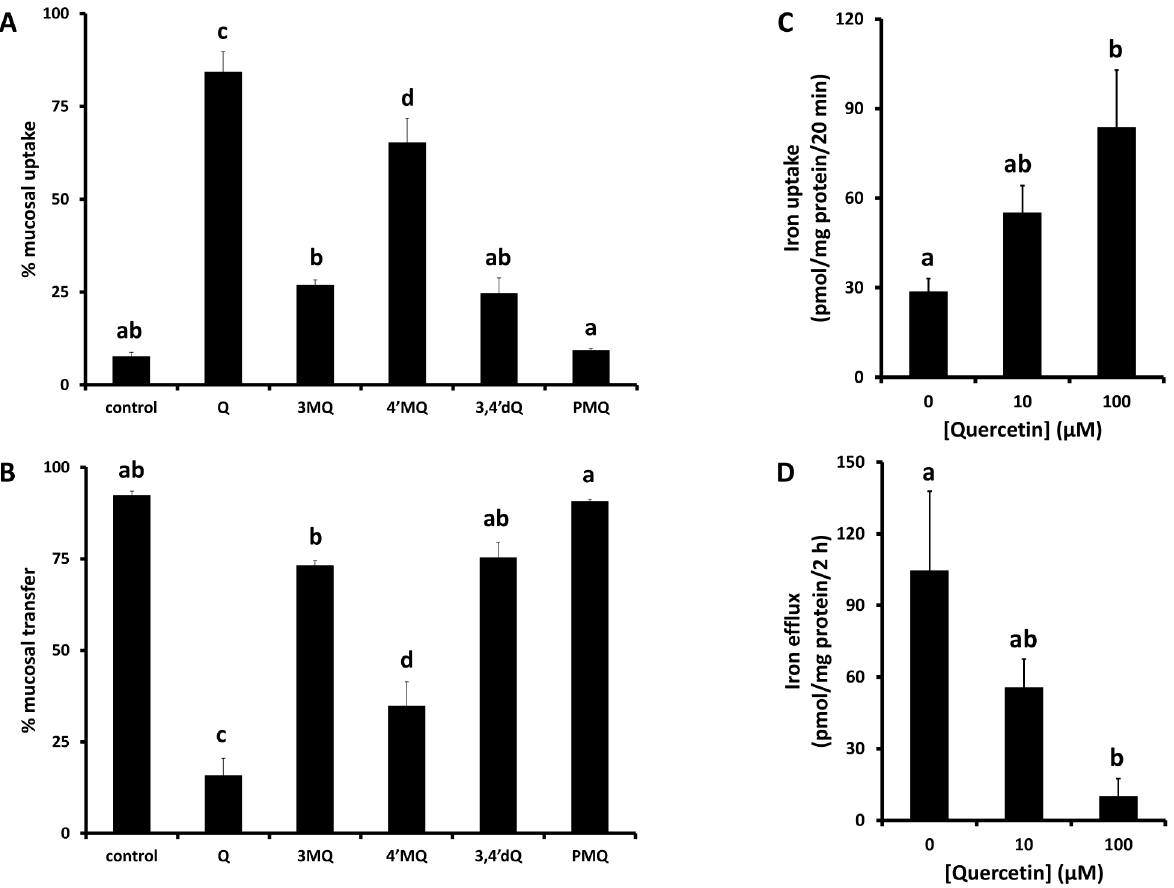
Figure 1. Acute effects of quercetin on intestinal iron transport. The acute effects of quercetin and its methylated analogues (3MQ, 4 9 MQ, 3,4 9 dMQ, PMQ) on iron transport in vivo were measured using the in situ duodenal loop method. 59 Fe (0.2 mmol/L) and polyphenol (1 mmol/L) were added to the lumenal uptake buffer and mucosal iron uptake (A) and mucosal transfer of iron into the circulation (B) measured. The effects of quercetin on iron uptake across the apical membrane (C) and iron efflux across the basolateral membrane (D) of human intestinal Caco-2 cells was also measured. Data are mean 6 SEM of 4 (rat duodenum) or 4–5 (Caco-2 cells) observations in each group. Groups with no common letters are significantly different from each other (one-way ANOVA and Tukey’s post hoc test; P , 0.05).